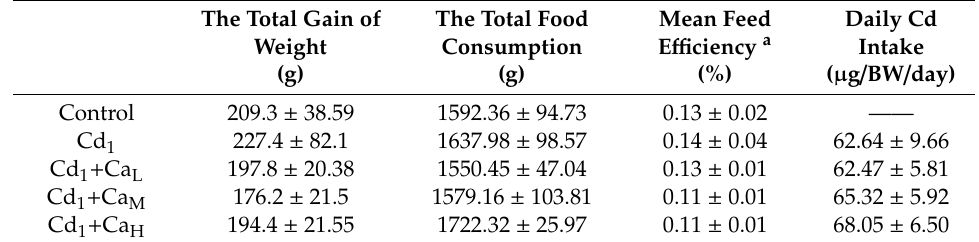
Table 3. Total weight gain, total food consumption, mean feed e ffi ciency, and daily Cd intake of female rats in the 90-day oral toxicity study of Ca supplementation with exposure to 1 mg Cd / Kg (Exp.